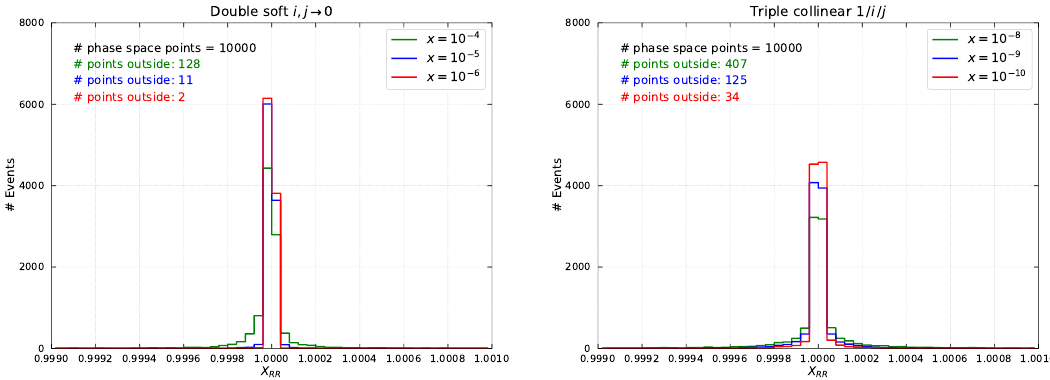
Figure 1 . Spike plots of the ratio d σ RR / d σ S verifying the correct behaviour of the subtraction terms for the R-term in the double soft gluons (left) and triple collinear q k g k g (right)